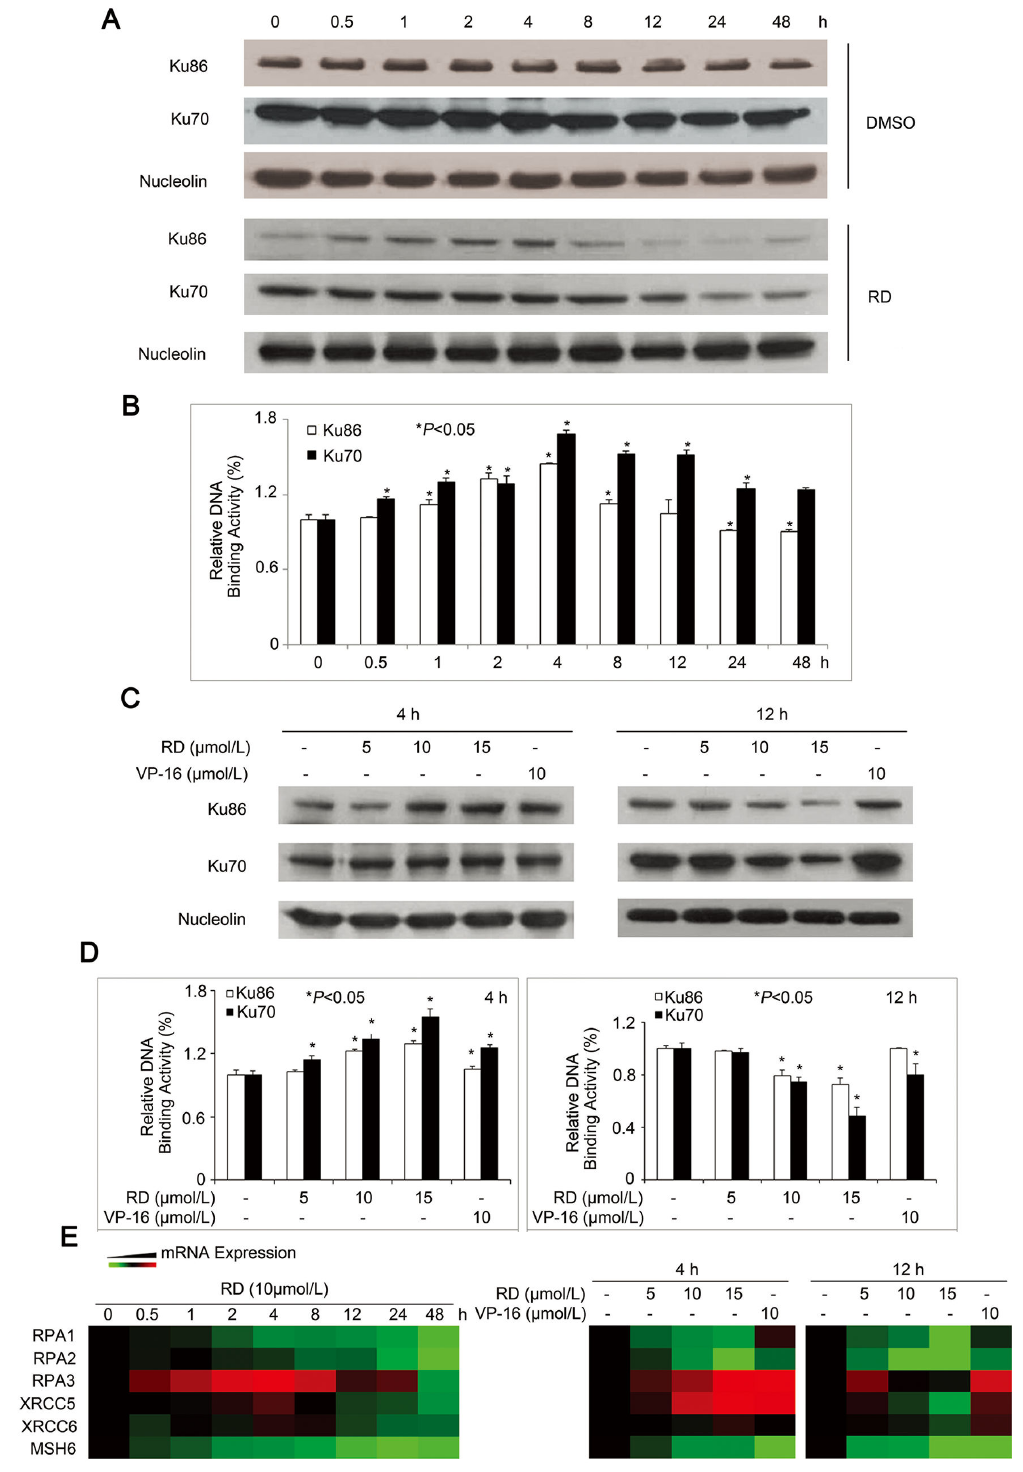
Figure 5. Effect of RD on DNA repair in PC-3 cells. A and C , Analysis of the expressions of Ku70 and Ku86 in nuclear proteins by western blot assay. B and D , Analysis of DNA end-binding activity of Ku70 or Ku86 in PC-3 cells exposed to RD. *, P < 0.05, significant difference from control. E , Heatmap for mRNA levels of DNA repair genes in RD-treated cells which were determined by real-time RT-PCR. Red: over-expression, green: under-expression, black: unchanged expression, gray: no detection. doi: 10.1371/journal.pone.0074387.g005 PLOS ONE |